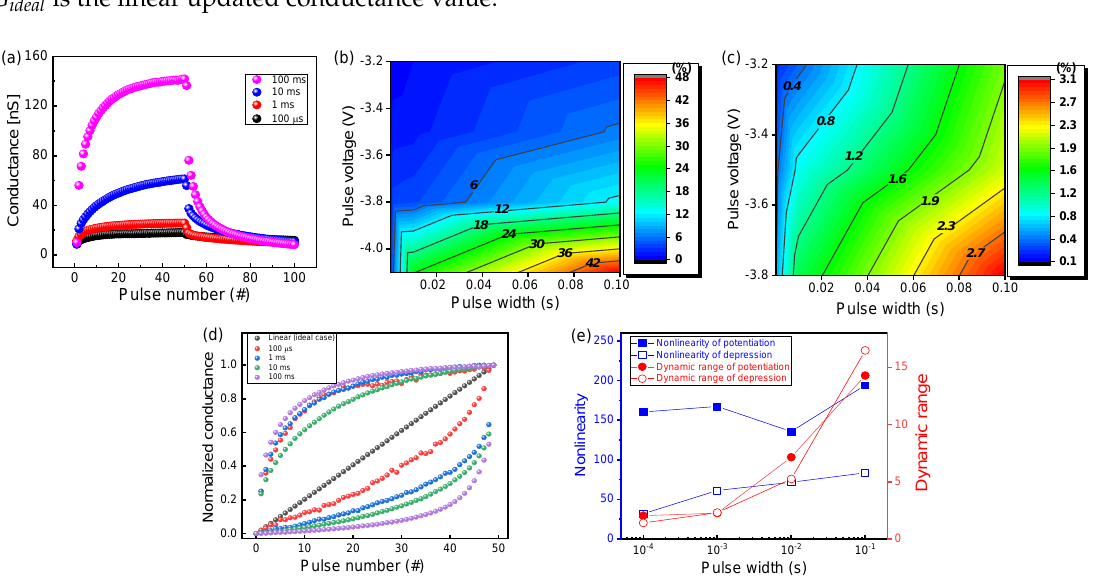
Figure 5. Short-term dynamics of TiN/Ti/TiO 2 /SiO x /Si device: ( a ) current was maintained by a short time interval (11 ms) after the set process; ( b ) current decayed from LRS in a long time interval (800 ms); ( c ) conductance decayed after 5 consecutive pulses were applied as a function of the time interval between pulses; ( d ) paired-pulse facilitation (PPF) as a function of interval time between paired pulses.